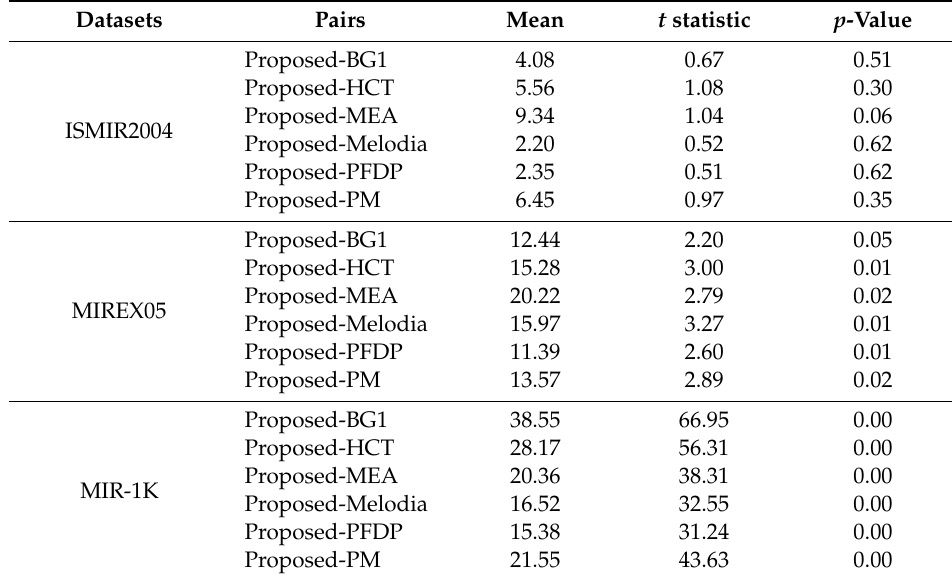
Table 3. Statistical significance analysis of a paired-sample t-test (OA) between the proposed and reference methods.